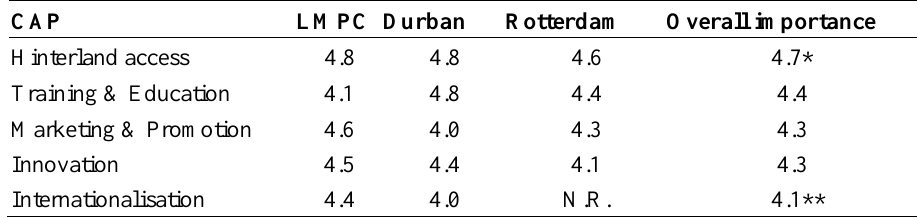
Table 5. The importance of five collective action problems in seaports CAP LMPC Durban Rotterdam Overall importance Hinterland